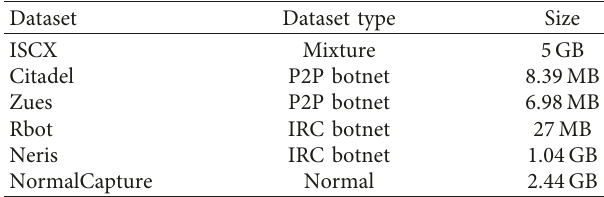
Table 2: Description of public